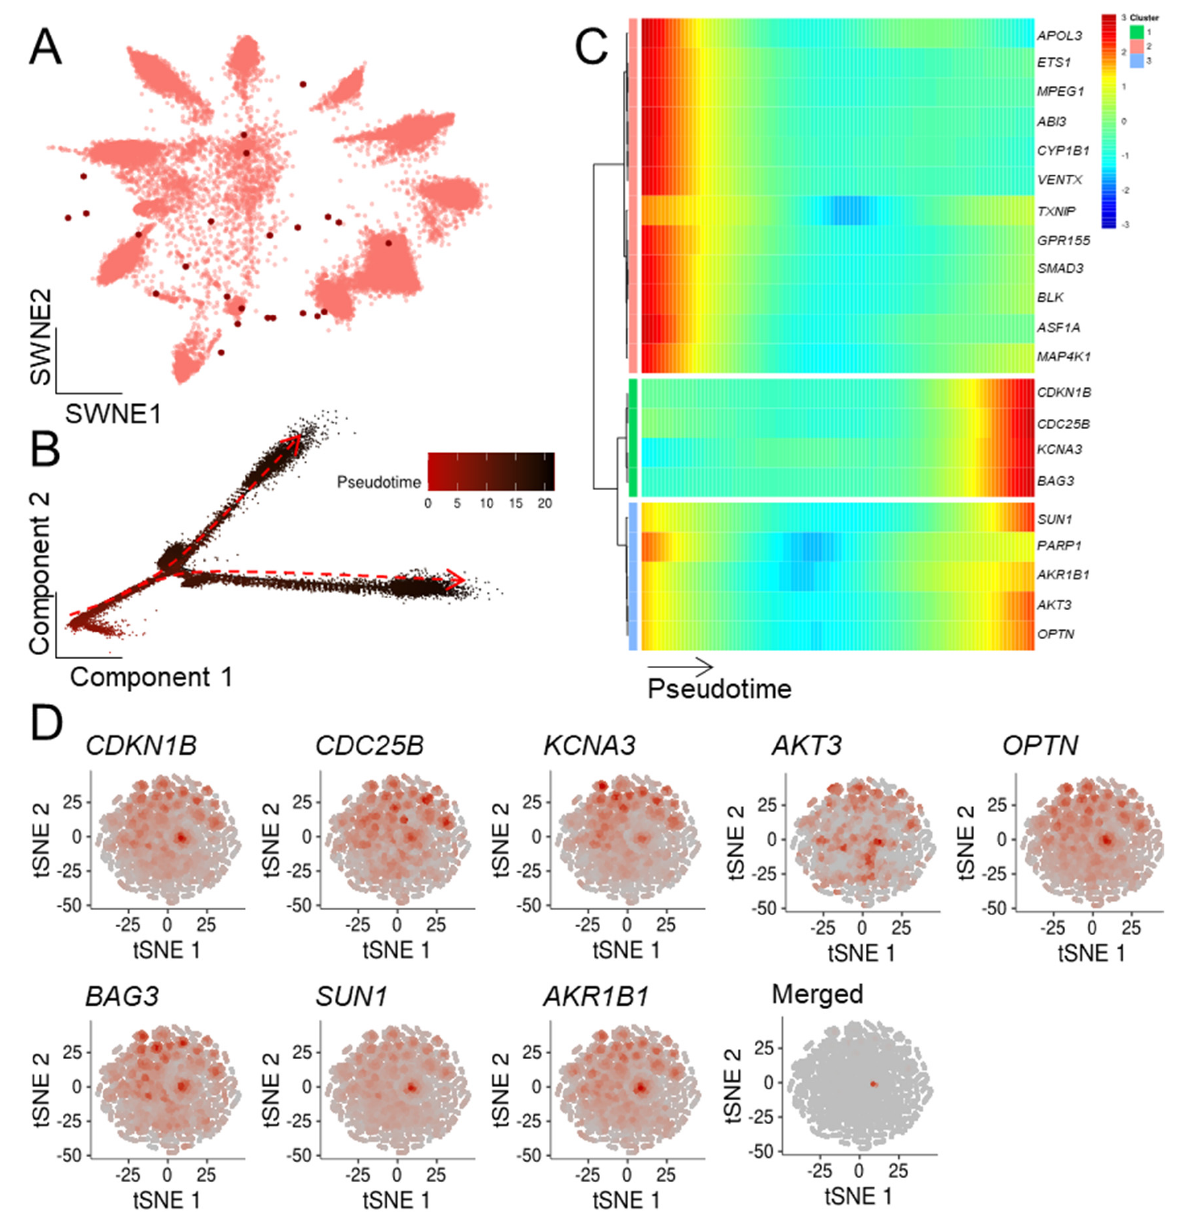
Figure 3. Within multiple myeloma cells, a distinct population of malignant cells displayed an upregulation of ASIGs. A publicly available malignant myeloma scRNA-seq dataset (15 patients; GSE175385 [49]) was downloaded and analyzed for transcriptional patterns of plasma cells. ( A ) The SWNE plot was weighted based on 24 previously defined, robustly expressed ASIGs (depicted as red dots). ( B ) Their developmental stage was presented in pseudotemporal ordering [55], indicating early (left, red) and late (right, black) fates. ( C ) Heatmap depicting ASIGs (green cluster) displaying significant upregulation during cellular development. ( D ) ASIGs enriched during late development were depicted in an independent tSNE representation. Merging expression patterns revealed a distinct plasma cell subpopulation with a high abundance of ASIGs.